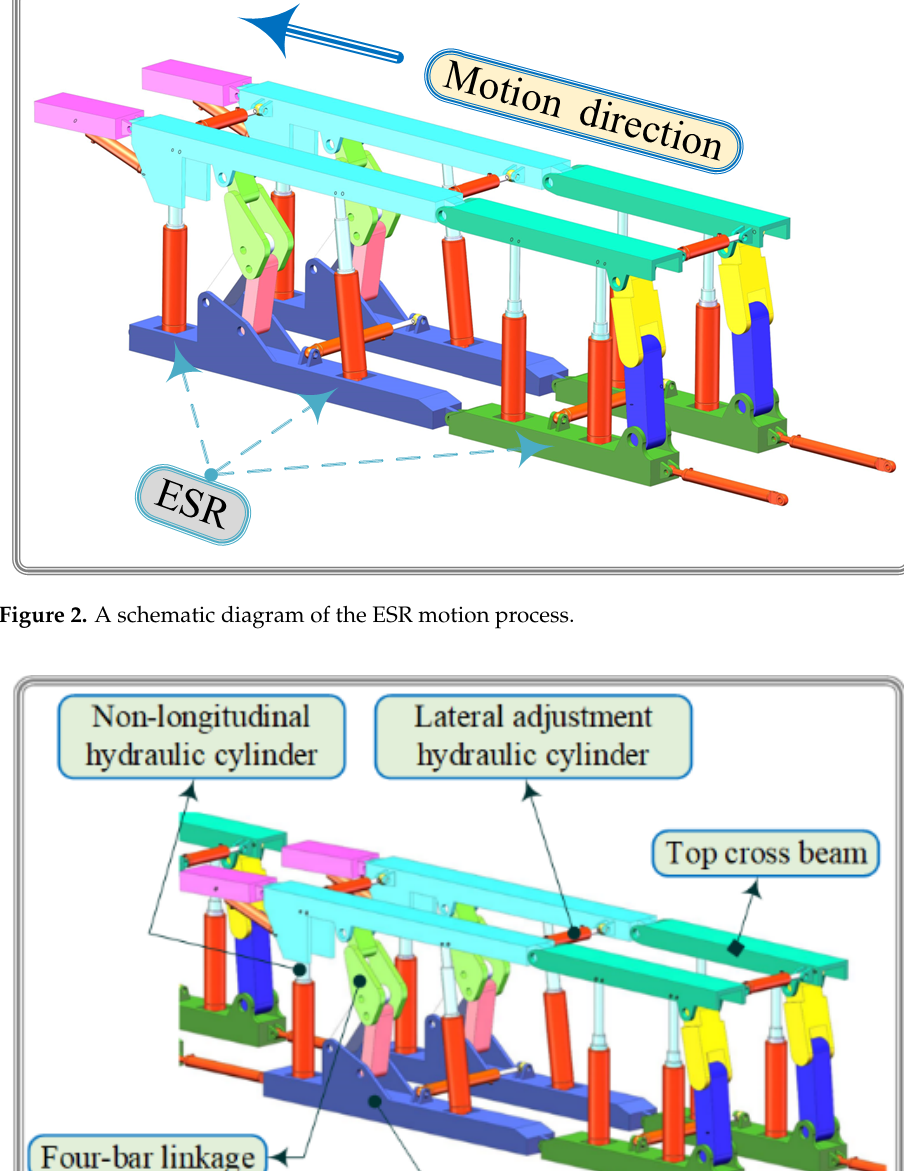
Figure 4. The geometrical dimensions of the core structure of the ESR.